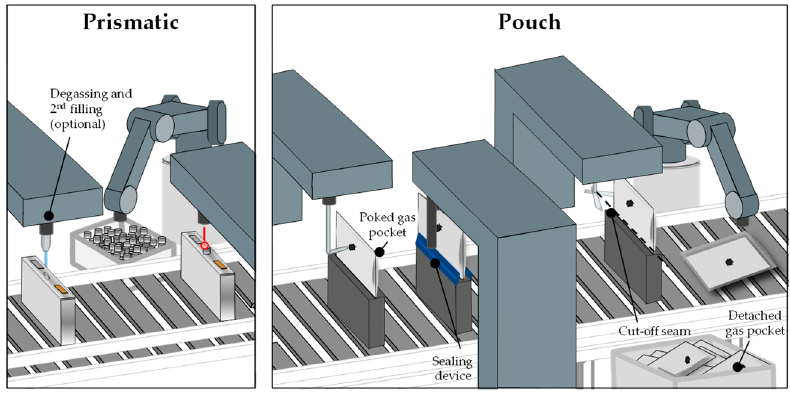
Figure 6. Schematic of the degassing and second filling [9] .